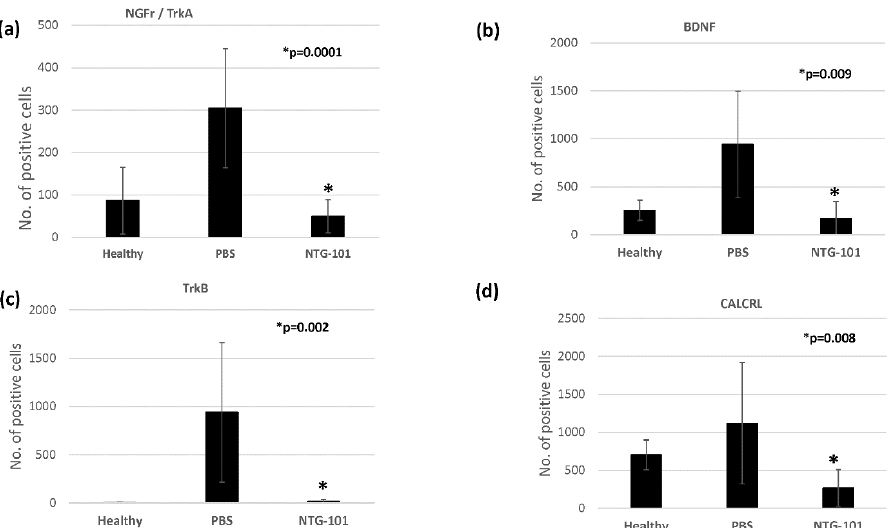
Figure 6. Histograms showing number of quantitative analyses of immunohistochemistry performed for ( a ) NGFr/TrkA, ( b ) BDNF, ( c ) TrkB and ( d ) CALCRL in canine IVD-AF tissue sections. * p -values for statistical significance for NTG-101 as compared to PBS-injected canine IVDs. Table 1. Human patient tissue donor characteristics and expression of neurotrophins (NGFr, BDNF, TrkB and CALCRL) in human degenerative IVD tissue